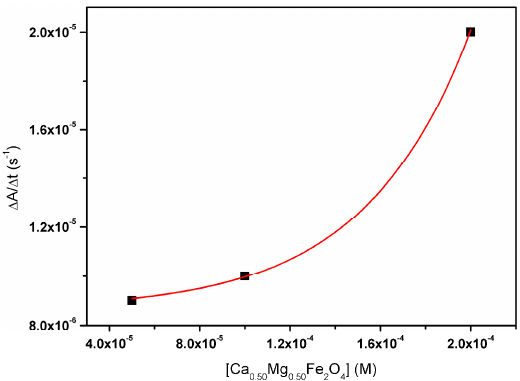
Figure 3. Sedimentation kinetics of Ca 0.50 Mg 0.50 Fe 2 O 4 nanoparticles.